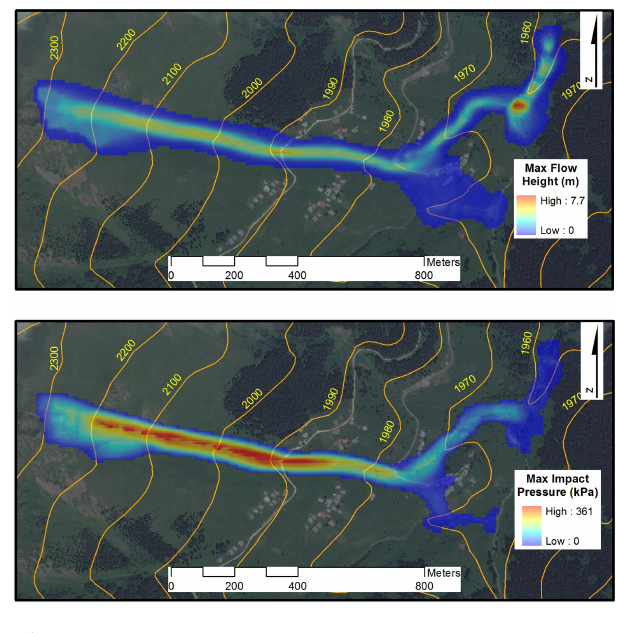
Fig. 11. Simulation result of Yaylaönü project area: maximum flow height (top) and maximum impact pressure (bottom).